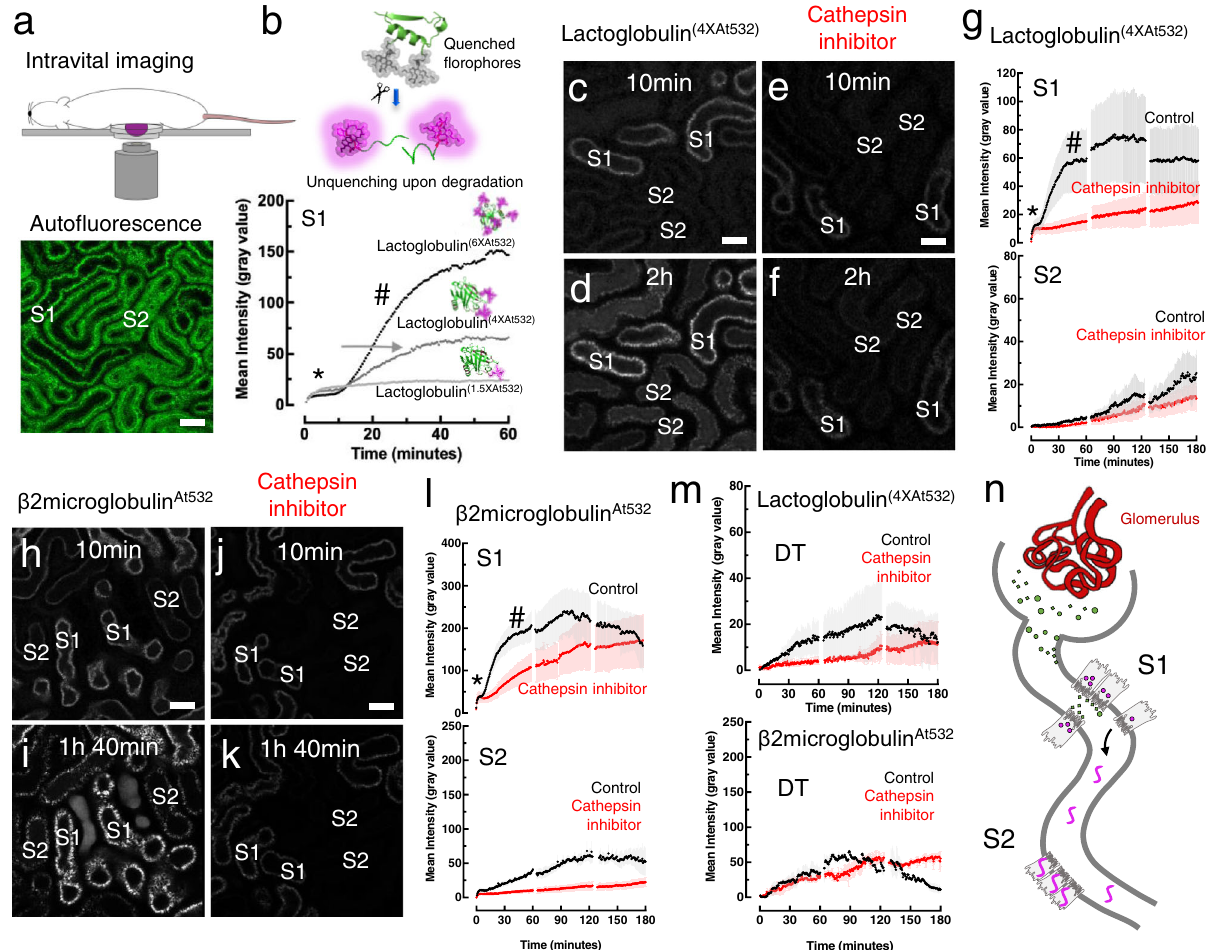
Fig. 1 | Filtered proteins are endocytosed, degraded and released from S1. a Early (S1) and late (S2) segments of the proximal tubule (PT) are distinguished in vivo by auto fl uorescence signals excited at 850nm (representative image of three independent experiments). b Fluorescence unquenching was used to detect protein degradation (#) in S1: signal increase was proportional to labeling density (*=uptake phase). An intermediate labeling density (arrowed) was used for sub- sequent experiments. Data were derived from regions of interest (ROIs) drawn around whole tubular segments ( n =3 mice). c – l Uptake and degradation of Lac- toglobulin (4XAt532) and β 2-microglobulin At532 along the PT. c , h 10min after injection, fi ltrationandS1uptakearecomplete. d , i DegradationthencommencesinS1anda